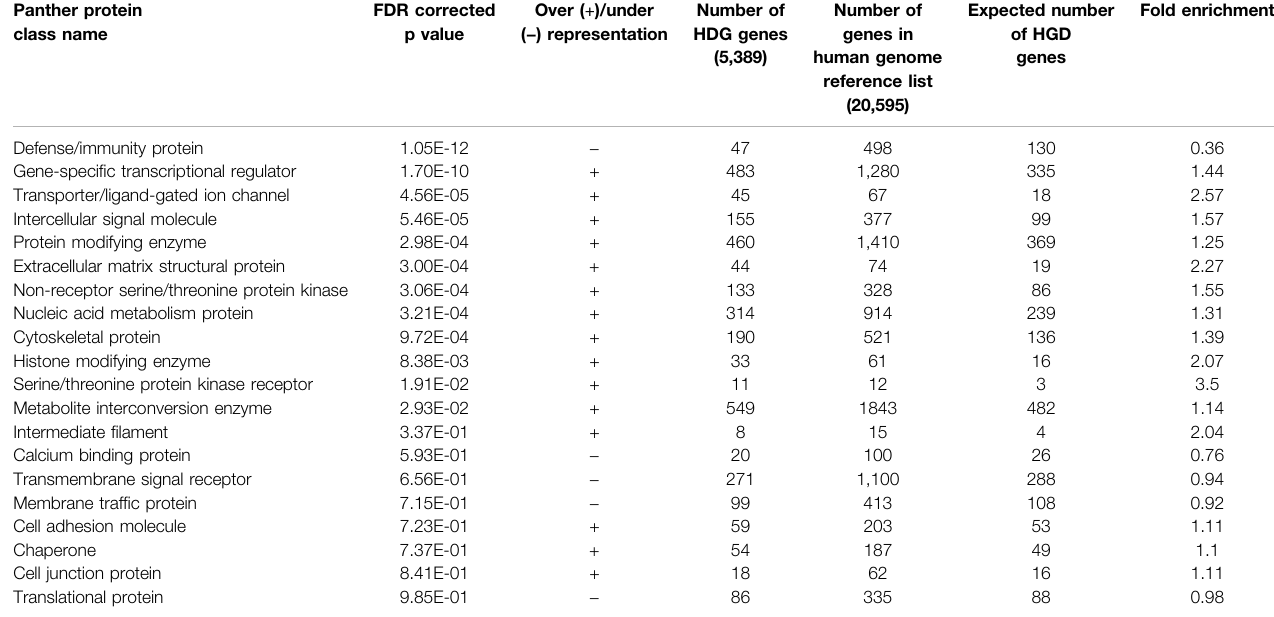
TABLE 1 | Proteins encoded by Genes in the Human DARTable Genome (HDG) by Protein Superfamily. Distribution of proteins encoded by genes in the HDG was determined by performing over (+) or underrepresentation ( − ) analyses of Panther Super Family Protein Classes (Mi, et al., 2020) using a false discovery rate (FDR) threshold of p < 0.05. Note that 1707 HDG genes were not classi fi ed by Panther. Panther protein class